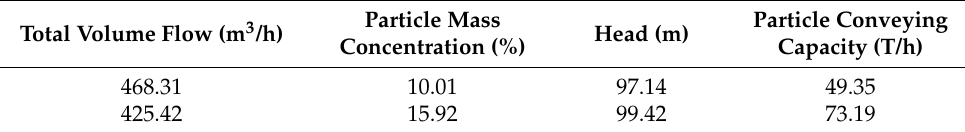
Table 6. Slurry conveying experimental results. Total Volume Flow (m 3 /h)